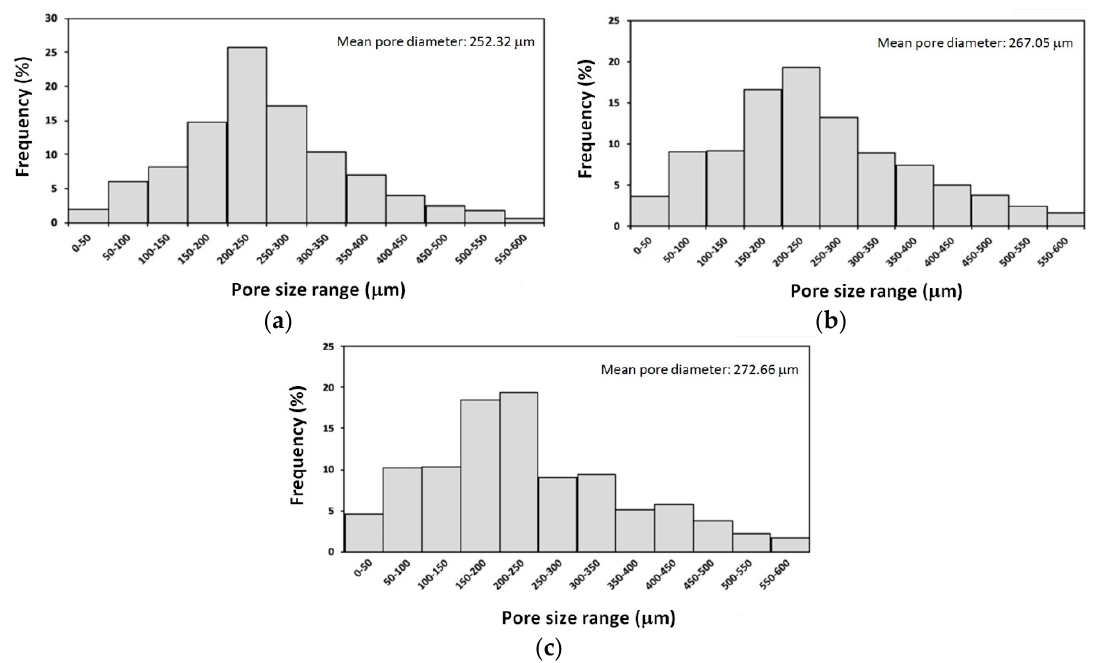
Figure 4. Porosity analysis results obtained using an imageJ image analyzer from three samples in each porosity range of ( a ) 55.9–58.7%, ( b ) 68.4–69.9%, ( c ) 76.4–78.0%.